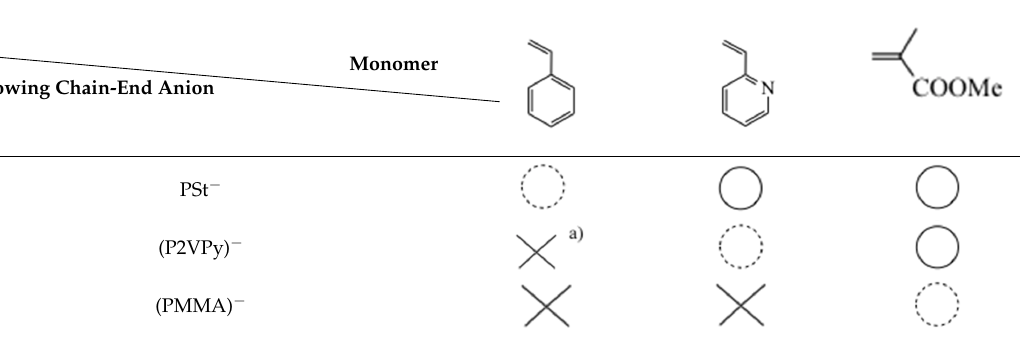
Table 9. Relationships among monomers and chain-end anions in polymerization.